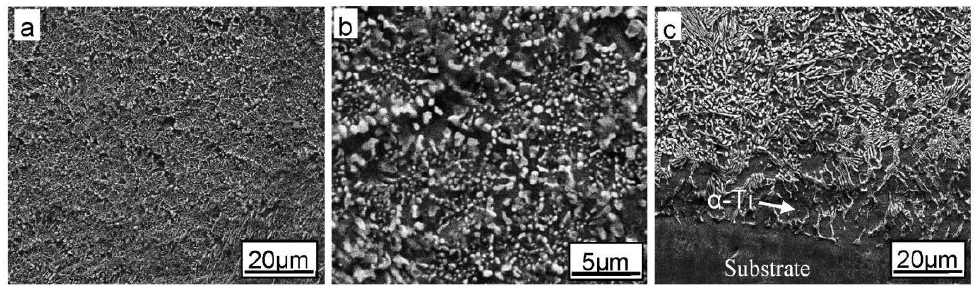
Figure 3. ( a ) Microstructure of the Ti–20%Si laser clad coating; ( b ) a higher magnification of ( a ) showing the fine eutectic structure; ( c ) the interface between the coating and the substrate.